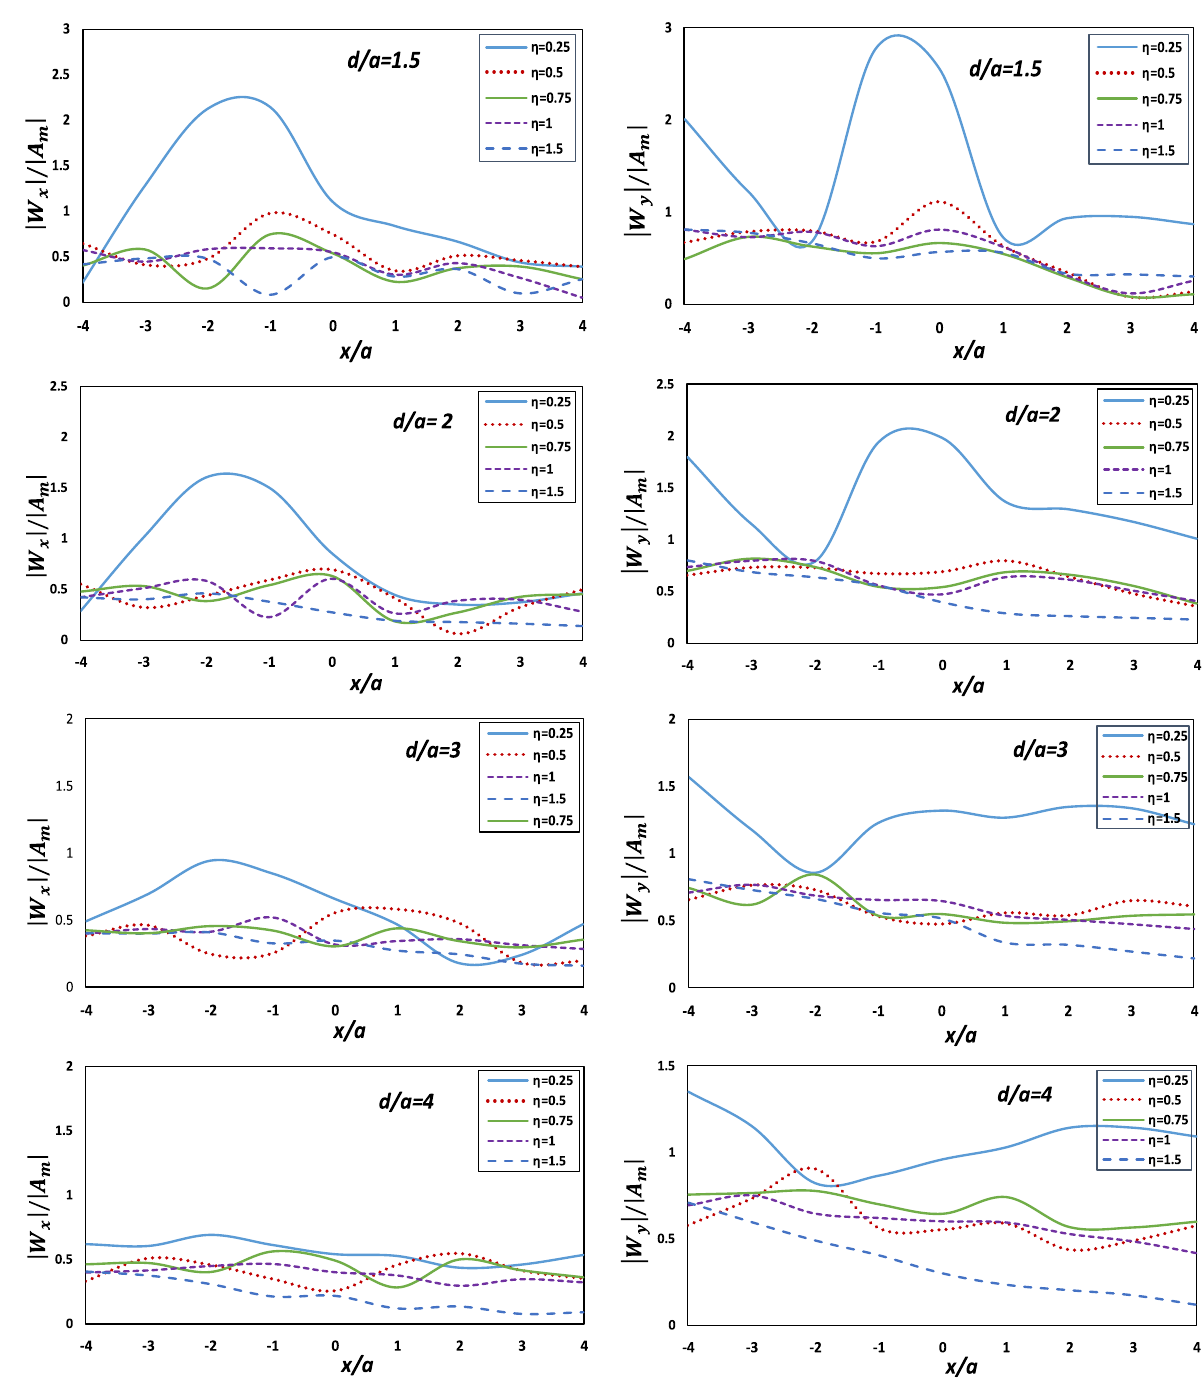
Fig. 10 Normalized amplitudes of the horizontal and vertical displacements of the ground surface with different wave frequencies at each constant depth ratio for incident